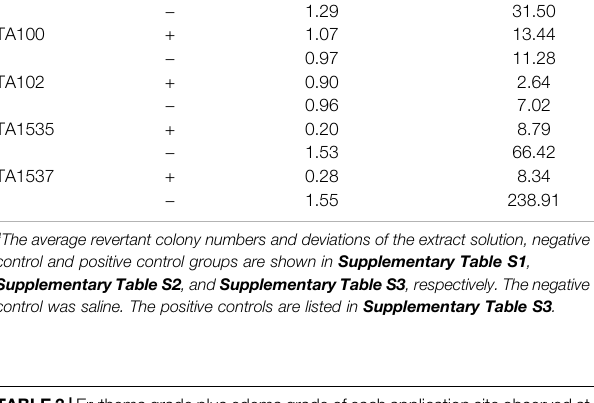
TABLE 3 | Erythema grade plus edemagrade ofeach application site observed at 1, 24, 48, and 72 h after removal of Fe 3 O 4 @Agar/HA.